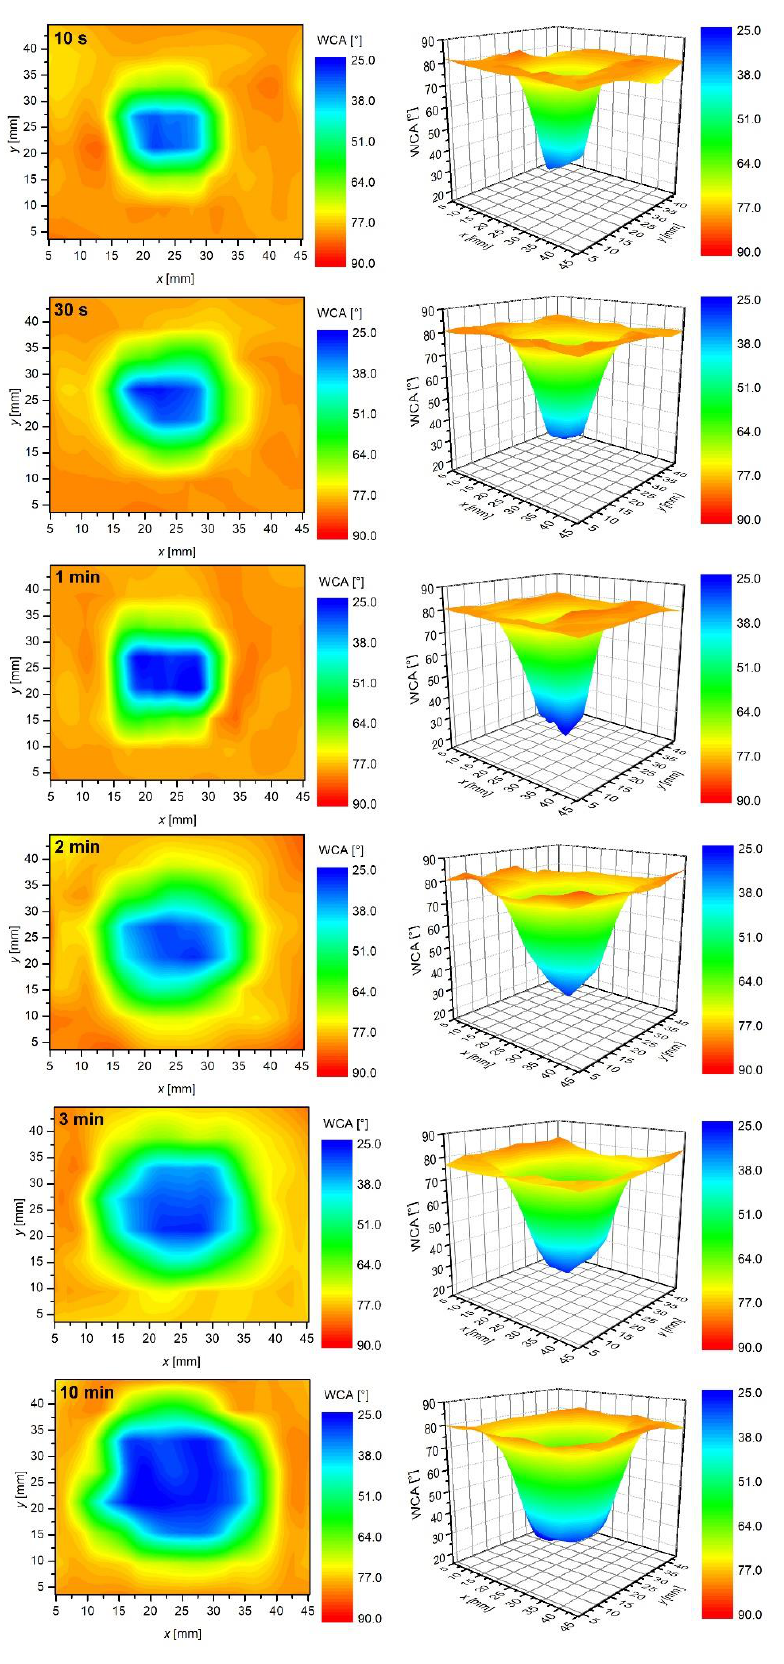
Figure 7. The time evolution of water contact angles on samples placed 5 mm below the APPJ nozzle.